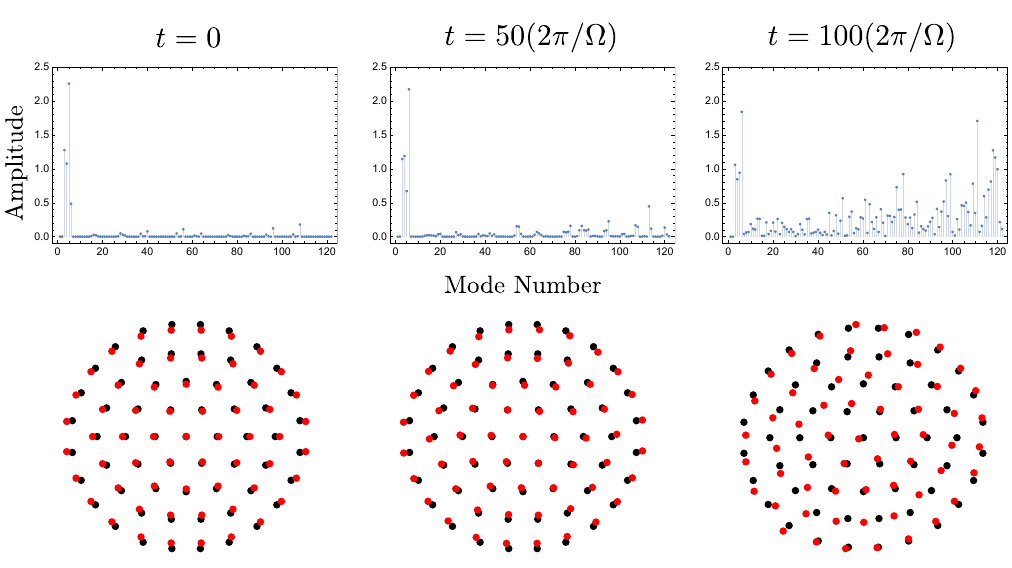
Figure 7: Nonlinear behaviour of the n = 1 mode in a lattice of size N = 61 = C with Ω = 1 (the radius of the lattice is of order 7). Left: an initial perturbation moves the vortices (red) from their equilibrium points (black) along an anti-holomorphic mode. In this case, the perturbation is by 0.05 z , giving a relative perturbation of 5%. Centre and right: the perturbation evolved nonlinearly after 50 and 100 periods respectively (in the rotating frame). After 50 periods the n = 1 mode retains a degree of coherency, after 100 periods it is no longer coherent. Top: eigenvector spectrum for the three lattices. The four prominent peaks corresponding to v clearly visible (see Figure 5).